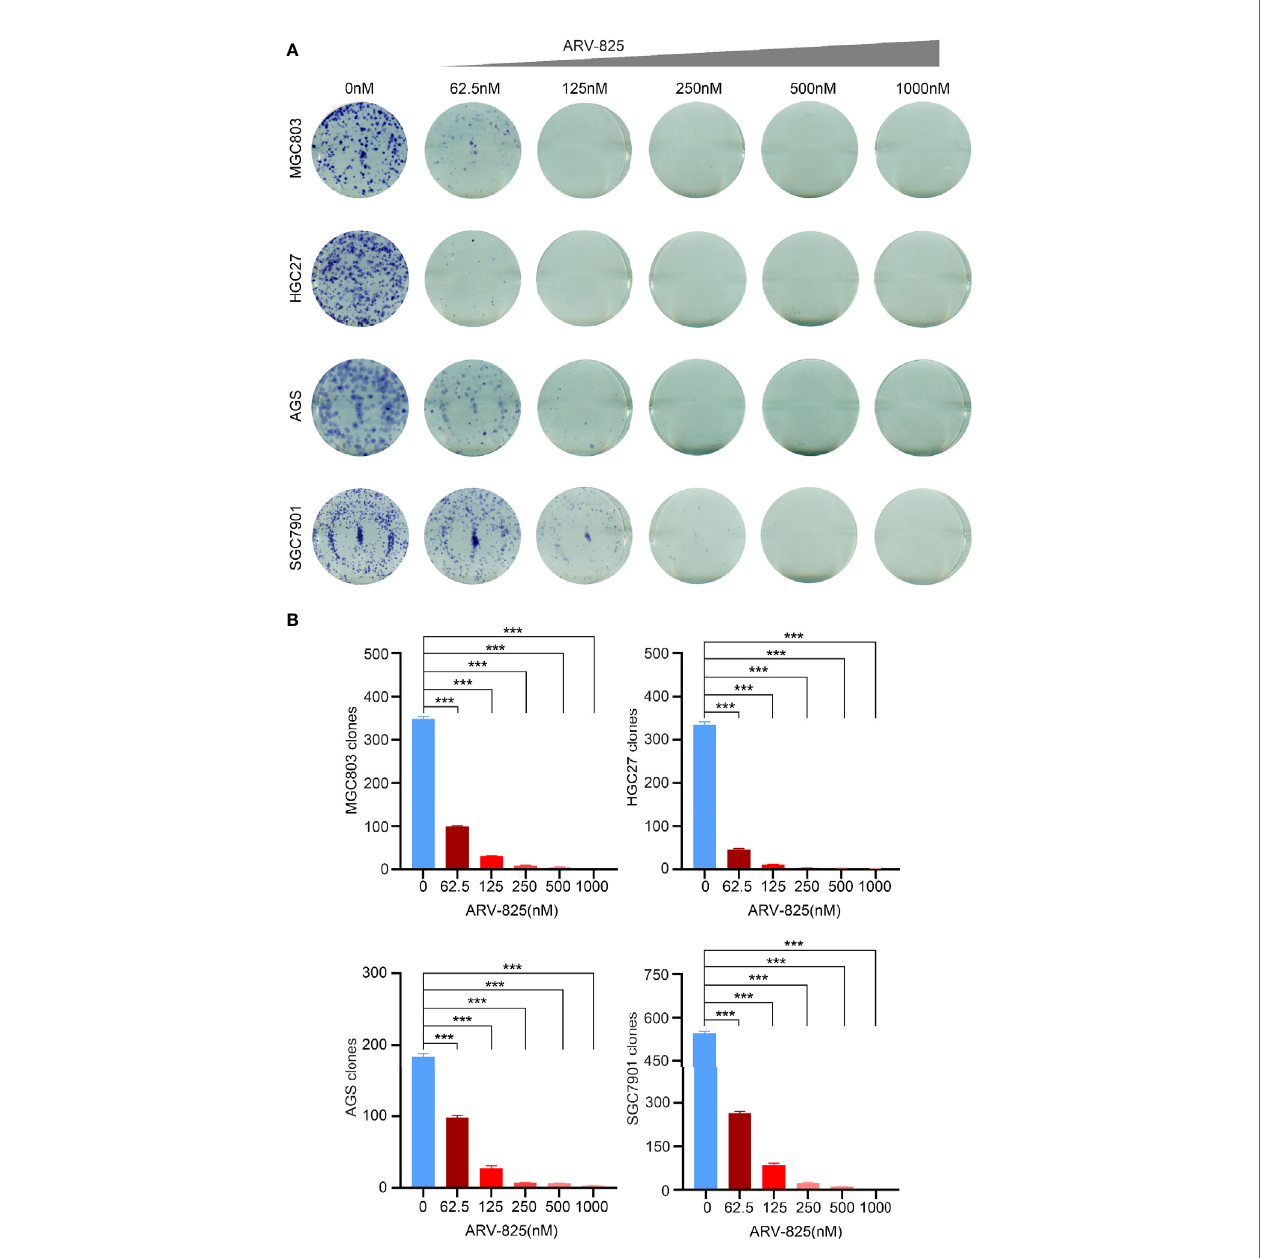
FIGURE 3 | ARV-825 suppresses clonal formation of gastric cancer cells. (A) ARV-825 suppressed dose dependently the clonal formation of gastric cancer cells. (B) Clone numbers of gastric cancer cells had remarkable difference between the ARV-825 treatment group and the control group. *** p <